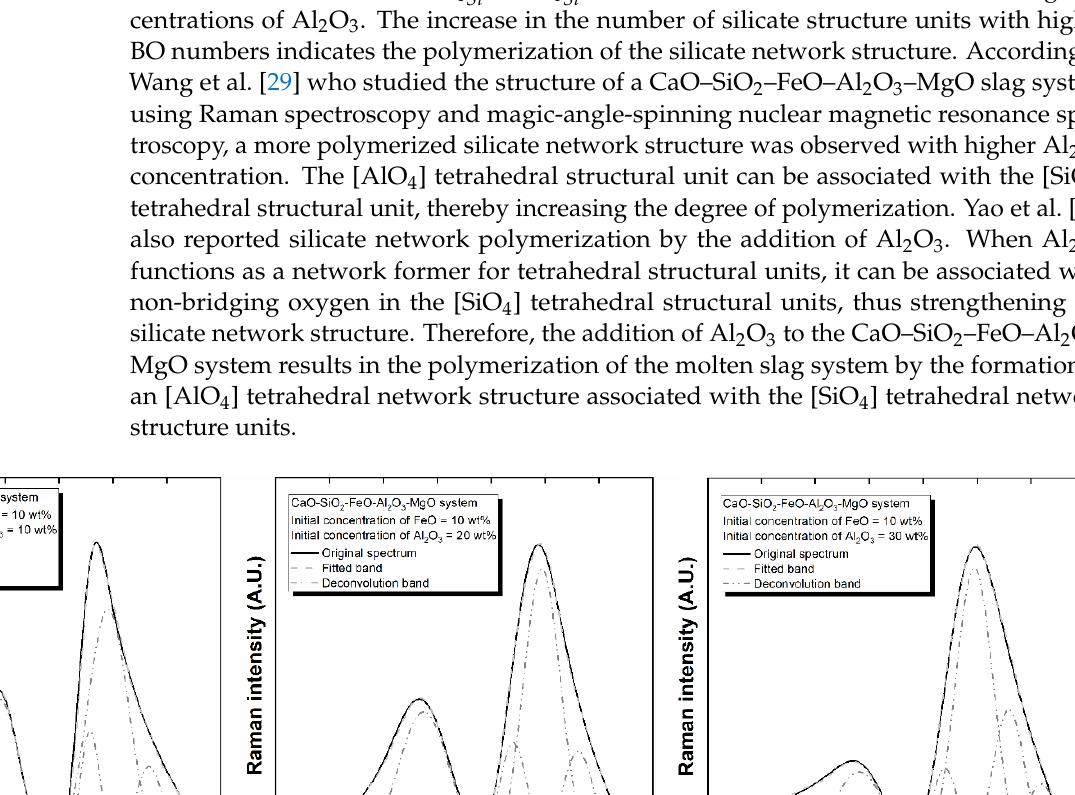
Table 2. Reference Raman peak positions and corresponding assigned aluminate and silicate units.